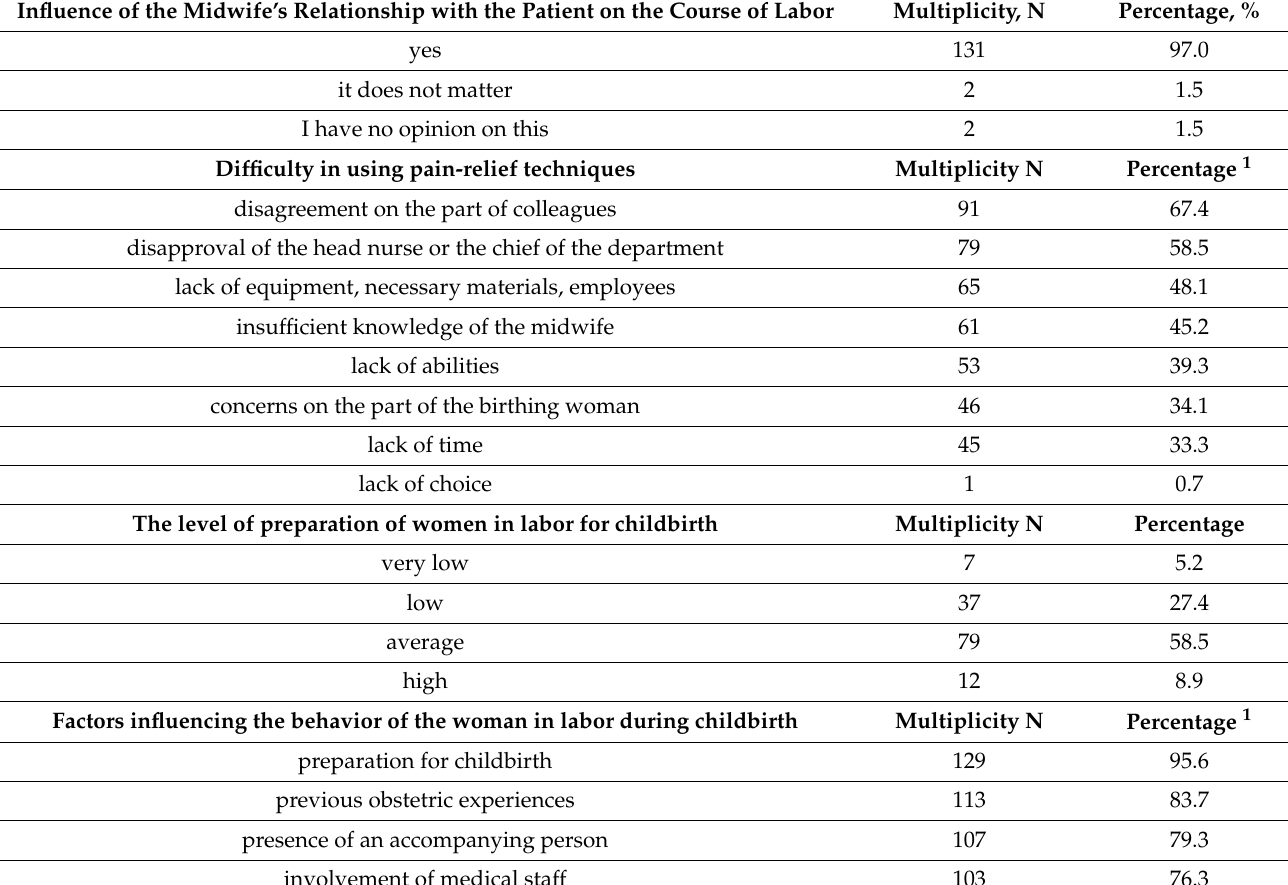
Table 2. Factors influencing the course of